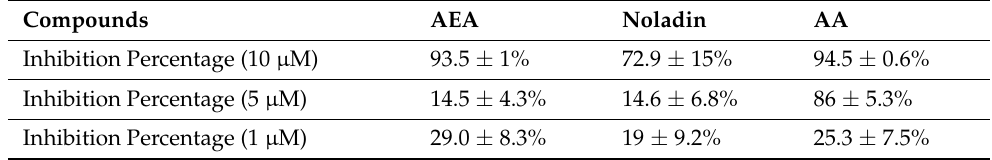
Table 1. Shows the inhibition percentage of ThT-monitored 24 h aggregation kinetics of A β 42 (5 µ M) in the presence of 1, 5, 10 µ M of AEA, noladin and AA at pH 7.4, 37 ◦ C in phosphate buffer at 24 h time point. Aggregation kinetics were monitored by ThT fluorescence spectroscopy (excitation = 440 nm, emission = 490 nm). Results are average ± SD of three technical replicates. Compounds AEA Noladin Inhibition Percentage (10 µ